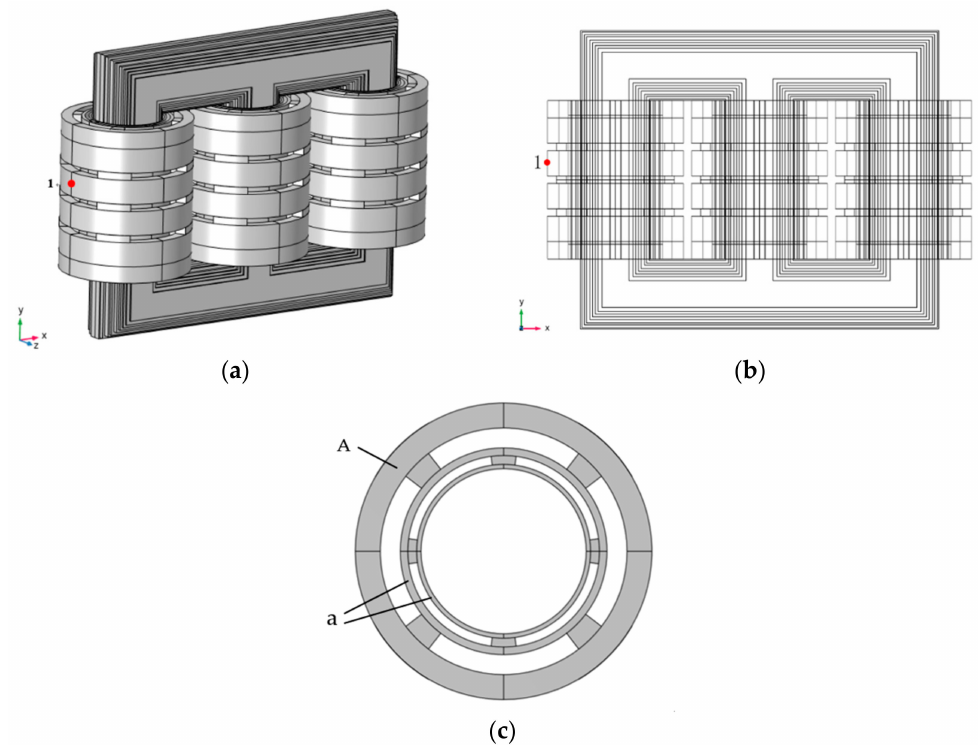
Figure 1. Overall model of the transformer and take point diagram. ( a ) Three-dimensional model; ( b ) a diagram for taking the points; ( c ) the top view of the winding.